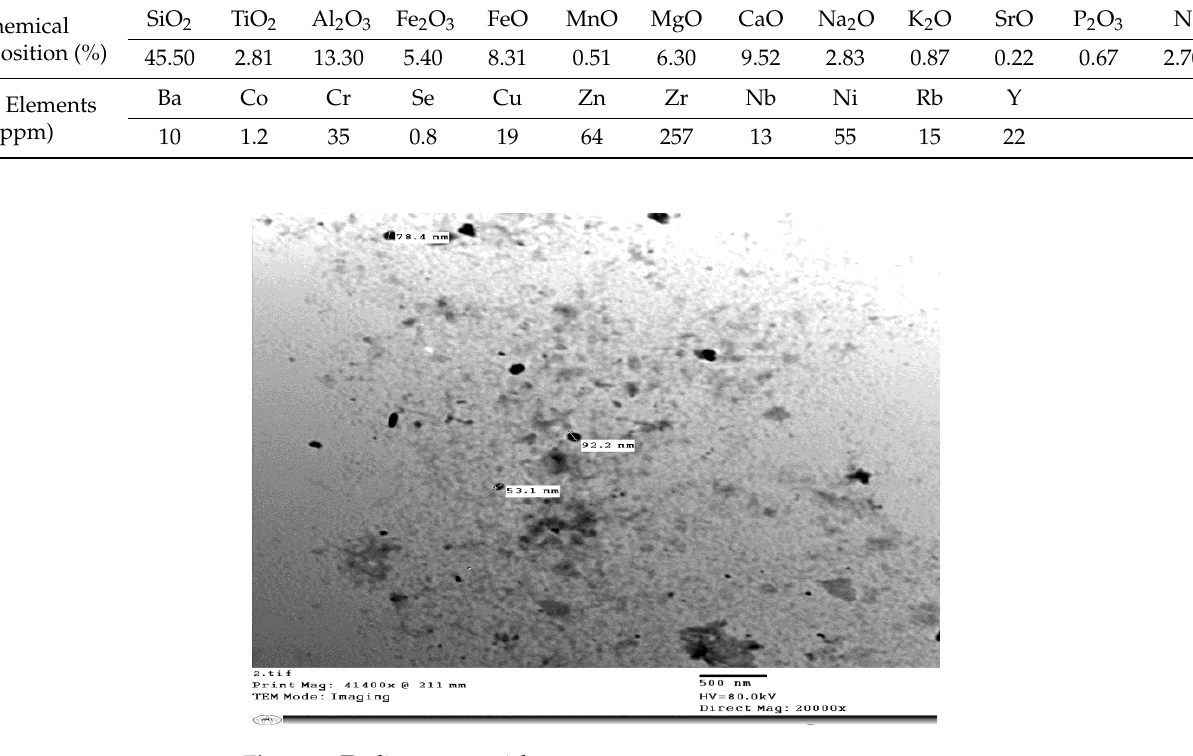
Figure 1. Zeolite nanoparticles.